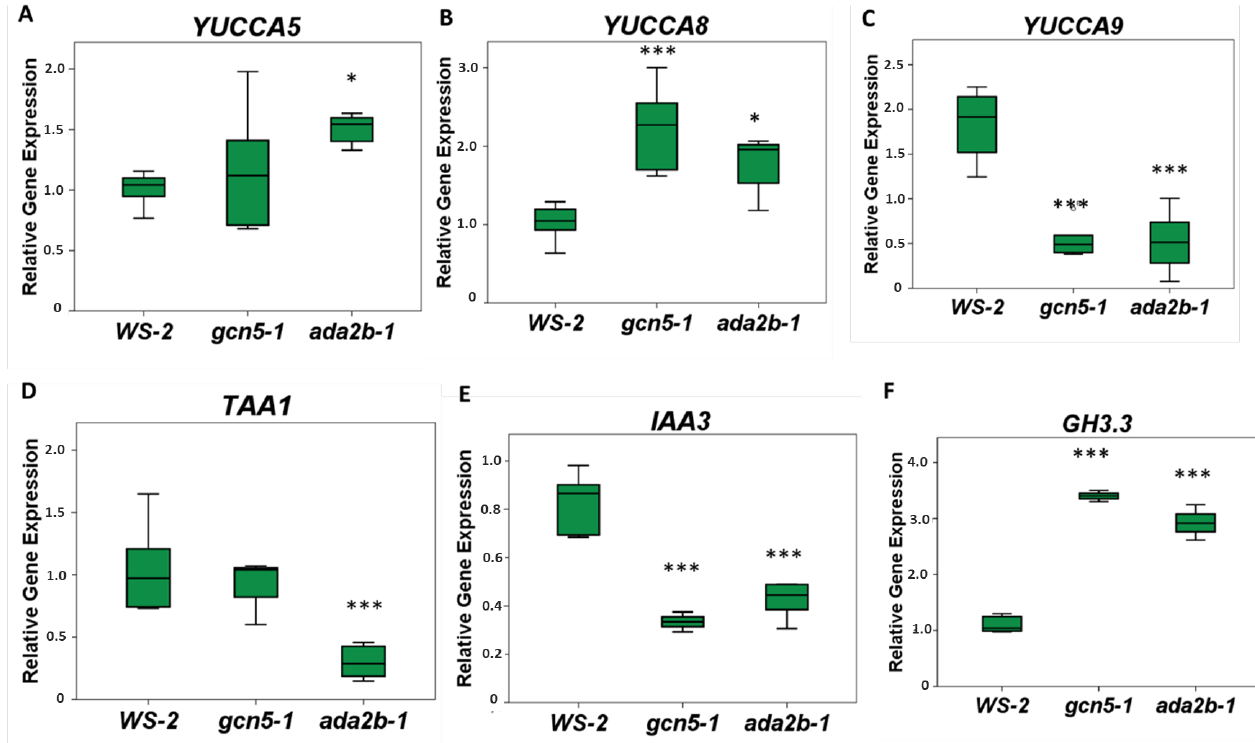
Figure 5. The role of GCN5 and ADA2b in auxin-related genes in Arabidopsis thaliana roots. The roots of seven-day-old Ws-2, gcn5-1 , and ada2b-1 seedlings were harvested for qRT-PCR analysis for the genes ( A ) YUCCA 5 , ( B ) YUCCA 8 , ( C ) YUCCA 9 , ( D ) TAA1 , ( E ) IAA3 and ( F ) GH3.3. The bars represent the range of the two quadrants. The horizontal line in the bar is the median, while the terminals are the minimum and maximum values of the data. Asterisks indicate the statistical significance based on an independent samples t -test: * p < 0.05 and *** p <